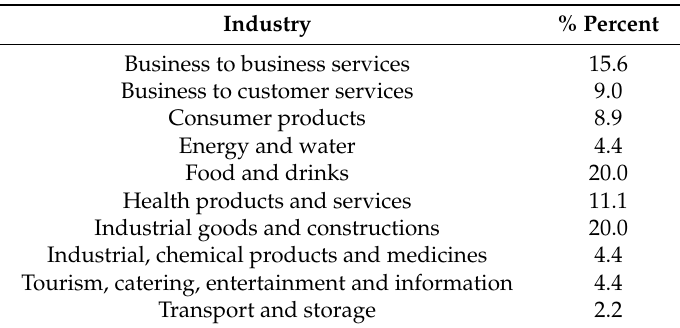
Table 2. Examined firms’